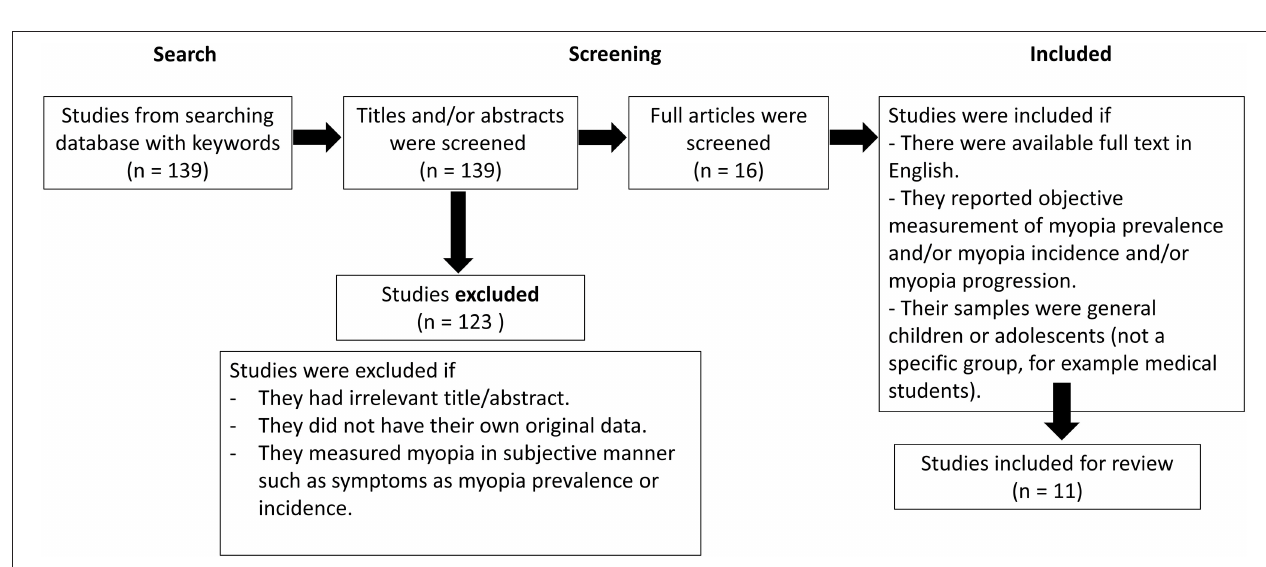
FIGURE 1 | Search and selection strategies of children’s behavioral changes during the COVID-19 lockdown.